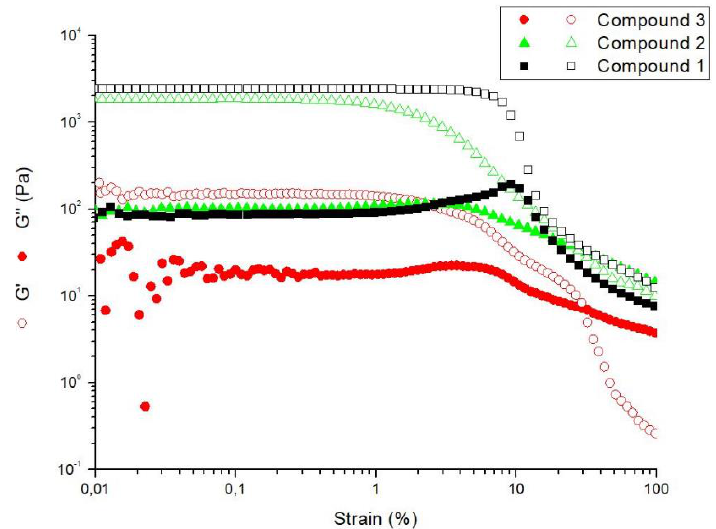
Figure 7. Strain dependence of the shear elastic G’ and loss G’’ moduli for dehydrodipeptides 1 – 3 at 0.20 wt%.